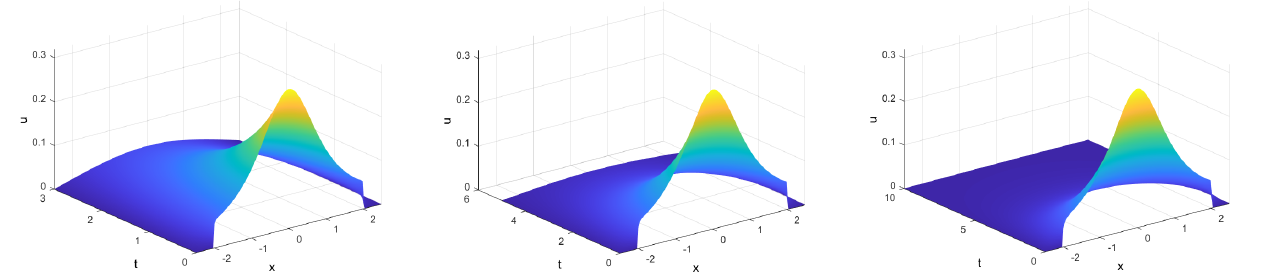
Figure 4. Solutions given by the method for t = 3,5 and 10 in the second